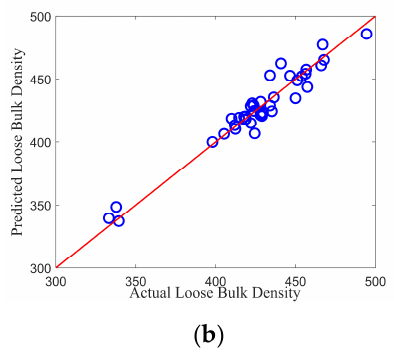
Figure 12. ( a ) R2 and Q2 versus the number of partial least squares (PLS) components for the PLS model of loose bulk density; ( b ) Predicted loose bulk density versus actual loose bulk density of IWMP samples.